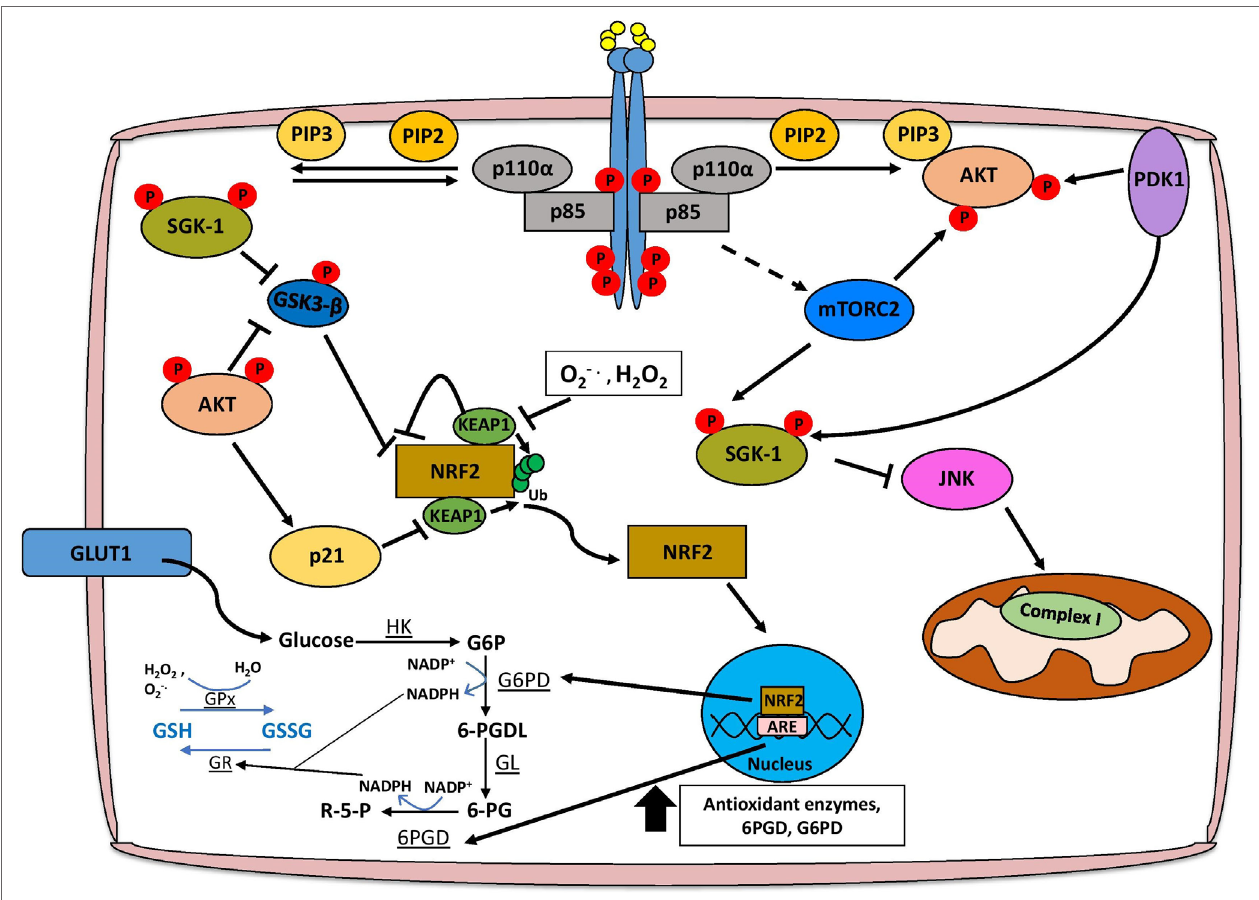
FiGURe 2 | PI3K/Akt signaling facilitates ROS detoxification and redox homeostasis. The concomitant increase in the cellular antioxidant response is necessary for redox homeostasis, and this is largely mediated through NRF2 signaling, glutathione metabolism, and production of NADPH. AKT facilitates the activation of NRF2 by inhibiting the interaction with KEAP1 and alleviating the negative regulation imposed by GSK3- β . Functional NRF2 translocates to the nucleus and transcriptionally activates genes involved in the antioxidant response such as glutathione S-transferase and superoxide dismutase, as well as the pentose phosphate pathway (PPP), which produces NADPH. Glutathione biosynthesis is an important antioxidant, which is regulated in a PI3K/Akt/Nrf2-dependent mechanism, and the conversion of glutathione between reduced (GSH) and oxidized (GSSG) forms is dependent on PPP-derived NADPH. Finally, Akt-independent signaling axes through SGK-1 may also promote ROS detoxification. Abbreviations: HK, hexokinase; G6P, glucose-6-phosphate; G6PD, glucose-6-phosphate dehydrogenase; 6-PGDL, 6-phosphogluconolactone; GL, gluconolactonase; 6-PG, 6-phosphogluconate; 6-PGD, 6-phosphogluconate dehydrogenase; R-5-P, ribulose-5-phosphate; GR, glutathione reductase; GPx, glutathione peroxidase; SGK, serum and glucocorticoid-regulated kinase; PI3K, phosphoinositide